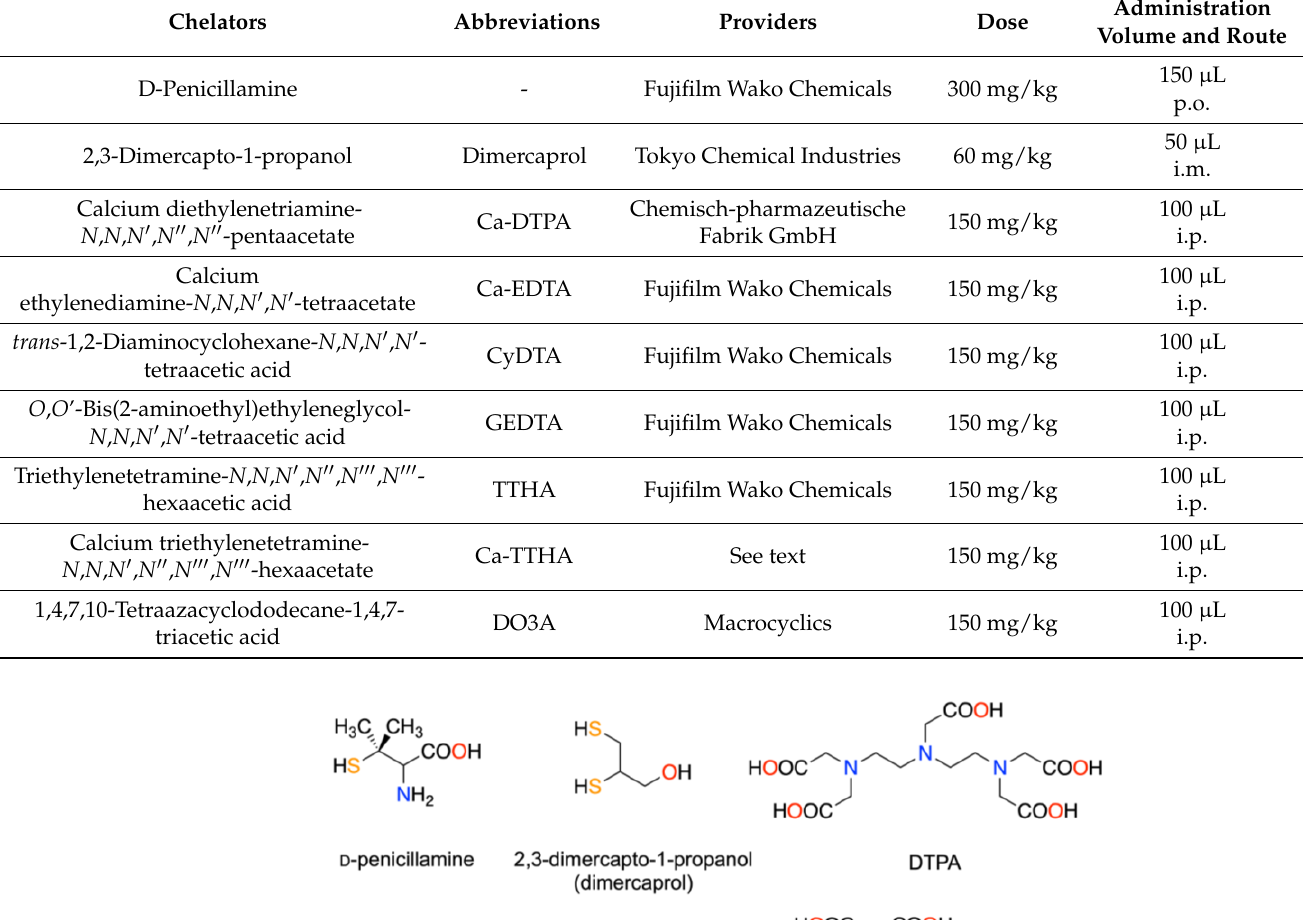
Table 1. Candidate chelators to reduce free actinium-225 ( 225 Ac) (dose, route, and information).